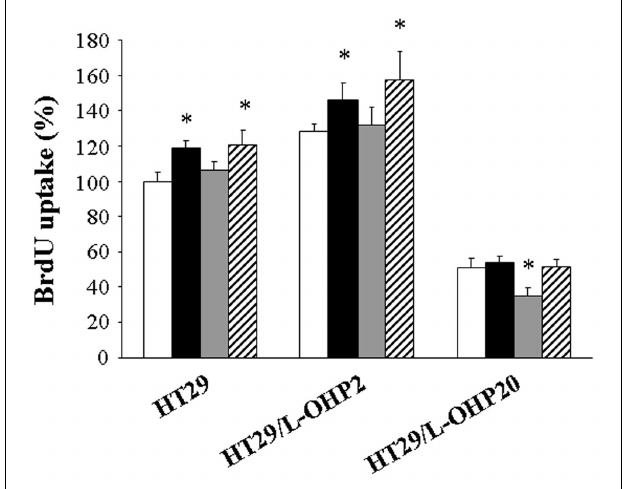
FIGURE 6 | Isoprenoids promote DNA replication in L-OHP-resistant HT29 cells. The parental HT29 cells and resistant HT29/L-OHP2 and HT29/L-OHP20 cells were treated for 48h without ( (cid:3) ) or with 1 μ M farnesol ( (cid:2) ) or 1 μ M farnesal ( ), and the BrdU uptake was measured in the cells. The cells were also pretreated for 2h with 25 μ M 4-hydroxyacetophenone prior to treating with 1 μ M farnesal ( ).Value is normalized to that in the control HT29 cells incubated without both isoprenoids and 4-hydroxyacetophenone, and expressed as the mean ± SD of three independent experiments. *Significant difference ( p < 0.05) from the control